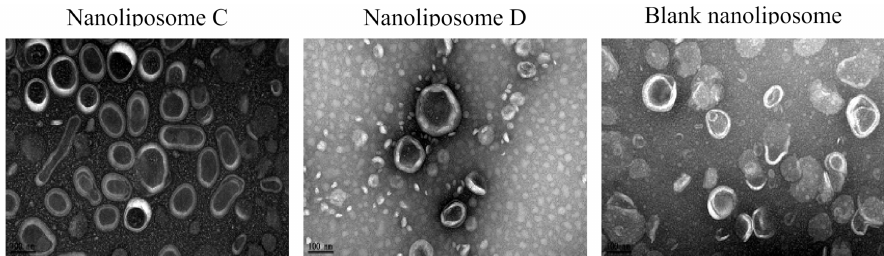
Figure 1. TEM morphological images of malB-loaded nanoliposomes: nanoliposome C (malB entrapped in nanoliposomes at 0.25 mg, EE = 78.73% ± 9.52%); nanoliposome D (malB entrapped in nanoliposomes at 0.50 mg, EE = 51.33% ± 16.53%). Blank nanoliposomal